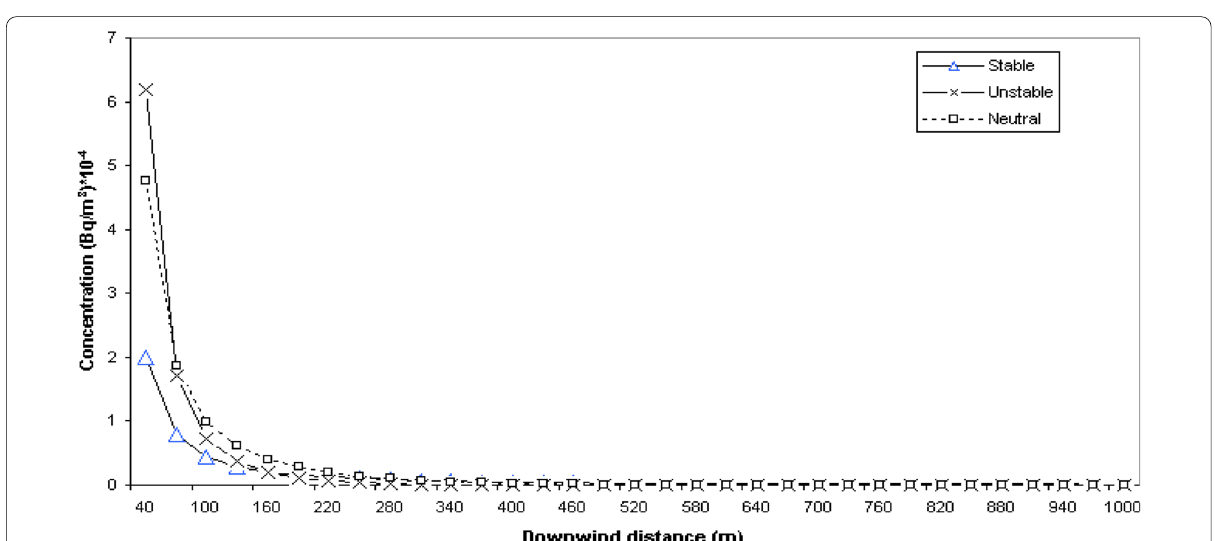
Fig. 7 The concentration for Cs‑137 via downwind distance through different stabilities classes when "H" depends on